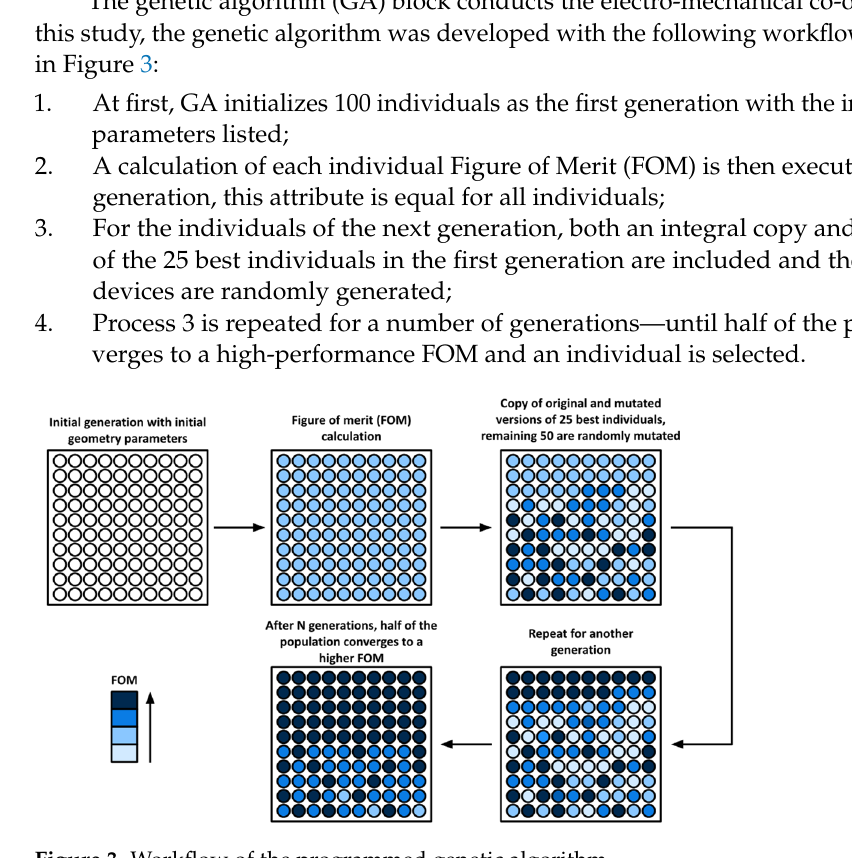
Figure 3. Workflow of the programmed genetic algorithm.